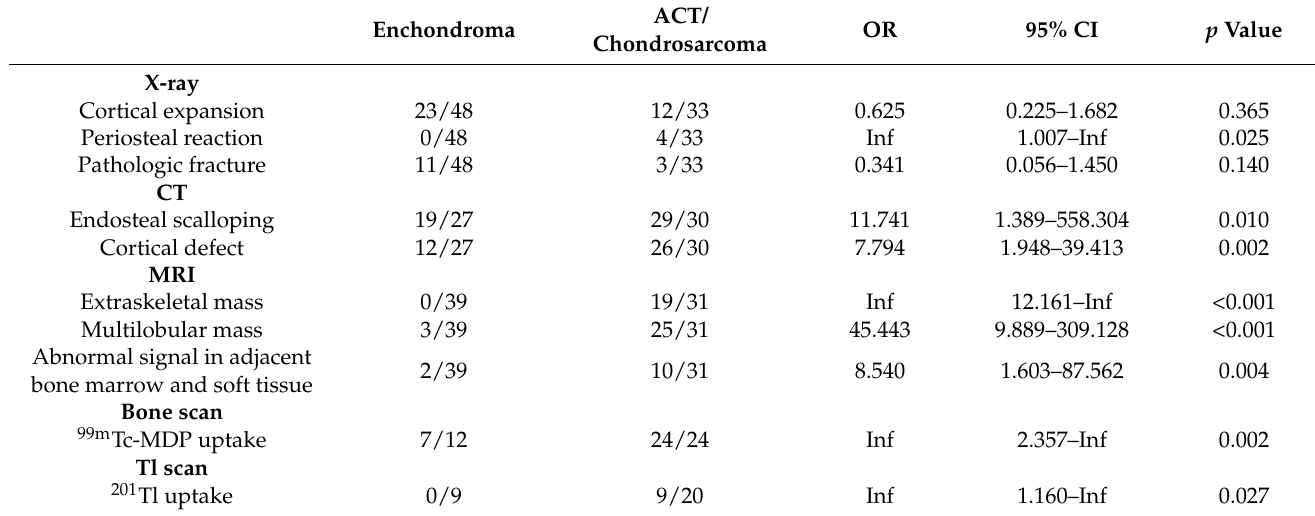
Table 2. Correlations between radiological findings and final diagnoses. Enchondroma